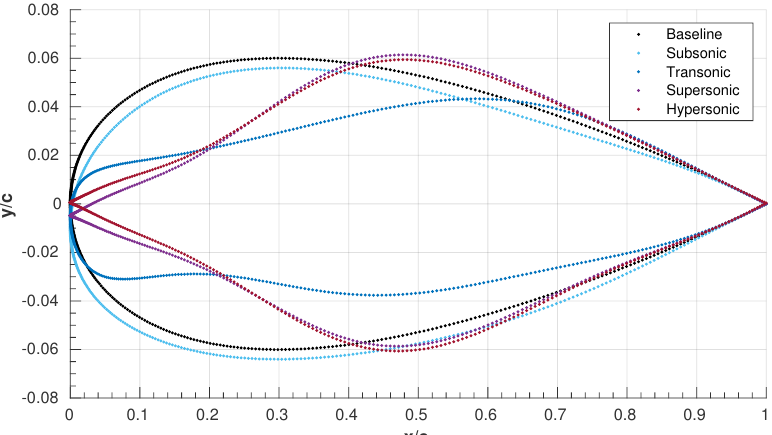
Figure 13. Baseline and optimized airfoil design geometries: overlap and comparison.